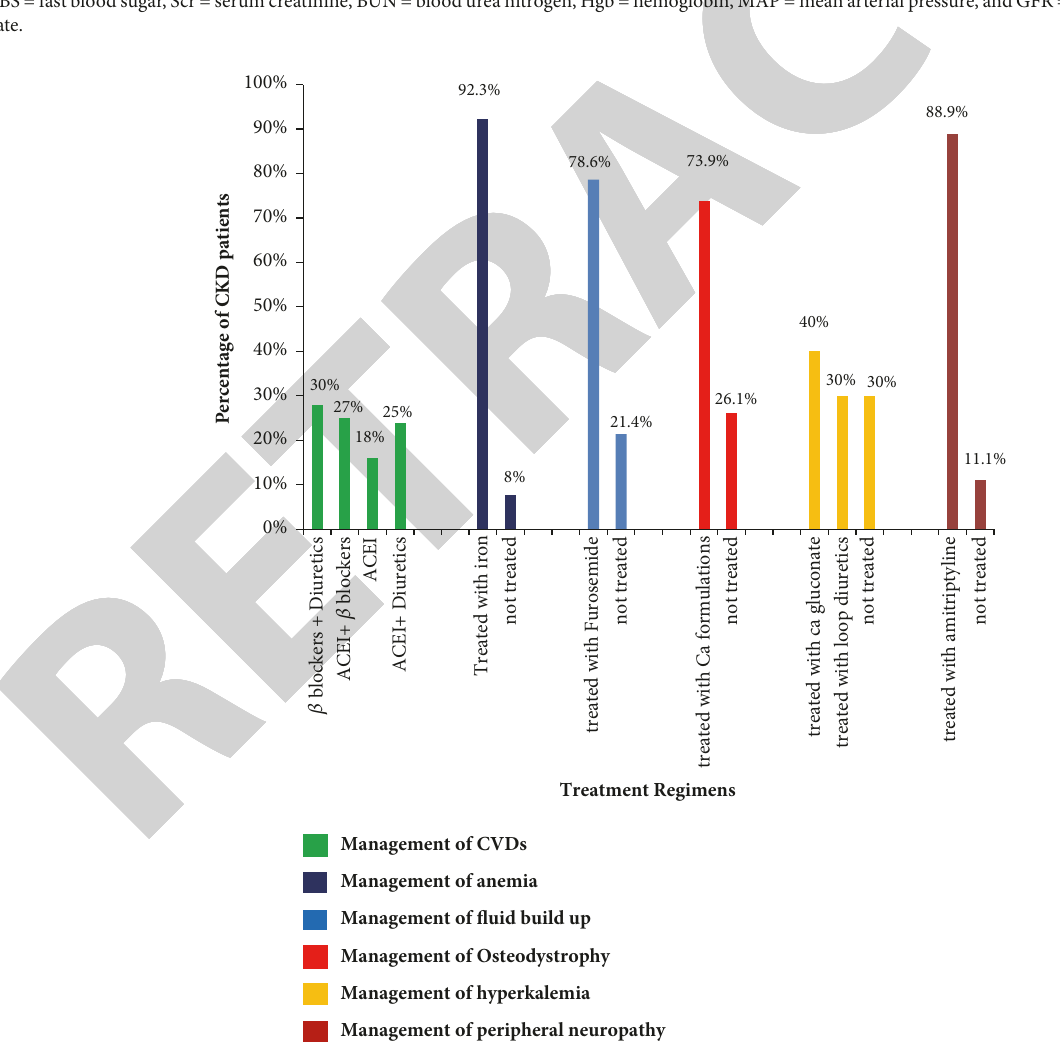
Figure 3: Management practice of complications among chronic kidney disease patients attending the renal clinic of Tikur Anbessa Specialized Hospital. ACEI: angiotensin converting enzyme